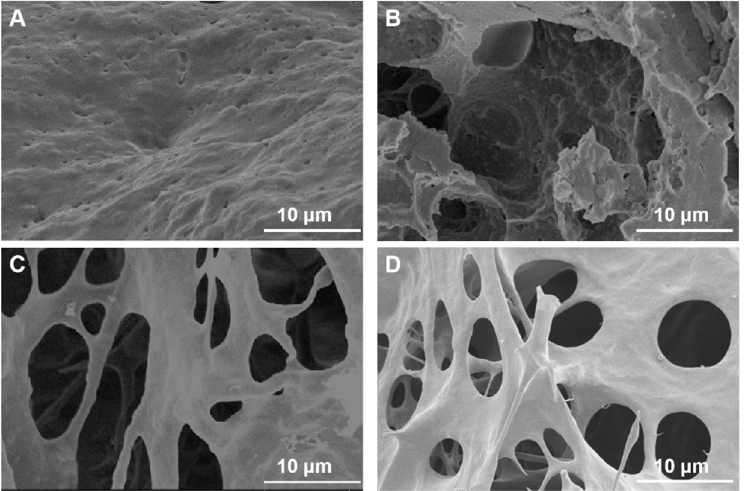
Figure 4. SEM images of CLIT-La (( A ) surface; ( B ) cross section) and CLIT (( C ) surface; ( D ) cross